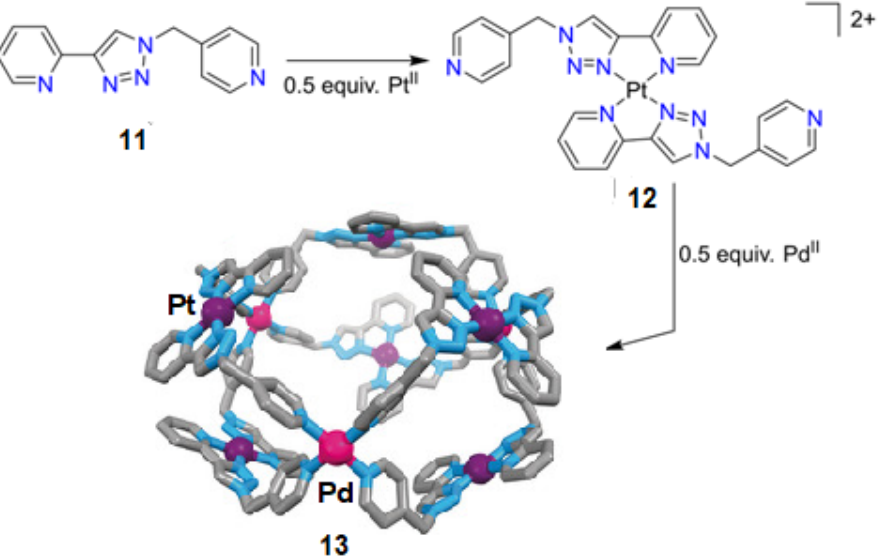
Figure 10. Metalloligand synthesis of the nona-nuclear heterometallic (Pd 3 Pt 6 ) cage 13 . Structure 13